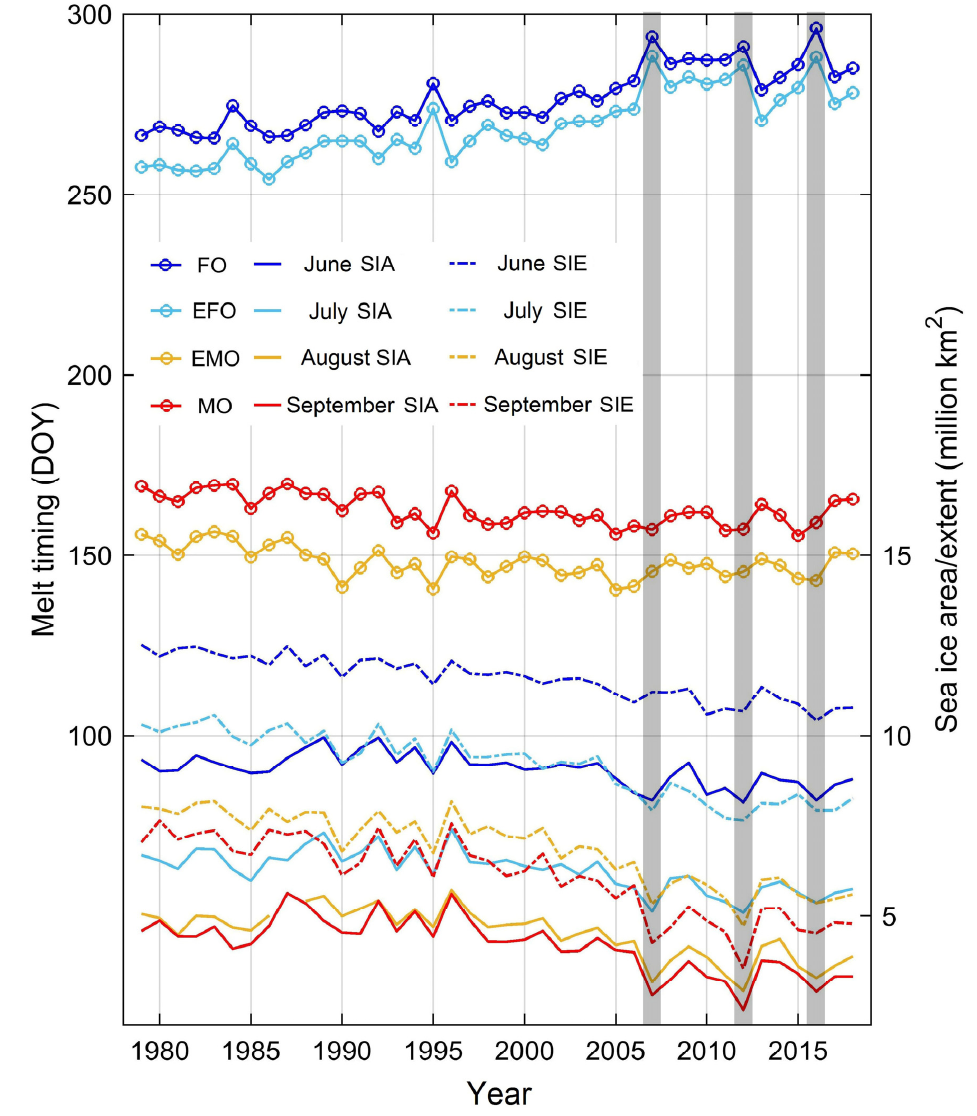
Figure 2. Variations in Arctic sea ice melt timing, monthly sea ice area (SIA), and sea ice extent (SIE) for 1979–2018. Gray shadows indicate the three years (e.g., 2012, 2007 and 2016) with the lowest SIEs and also the latest EFO and FO on